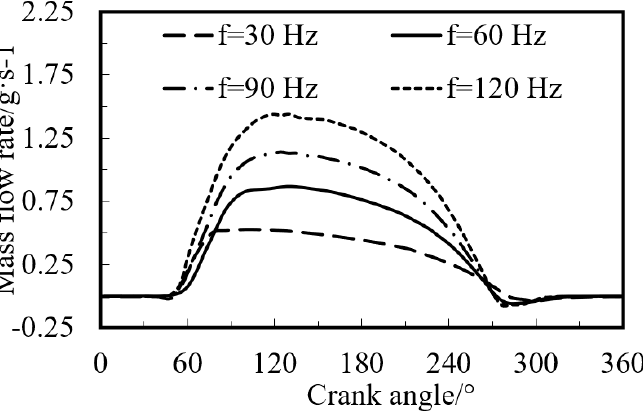
Figure 15. Variations of mass − flow rate with the crank angle for different frequencies.